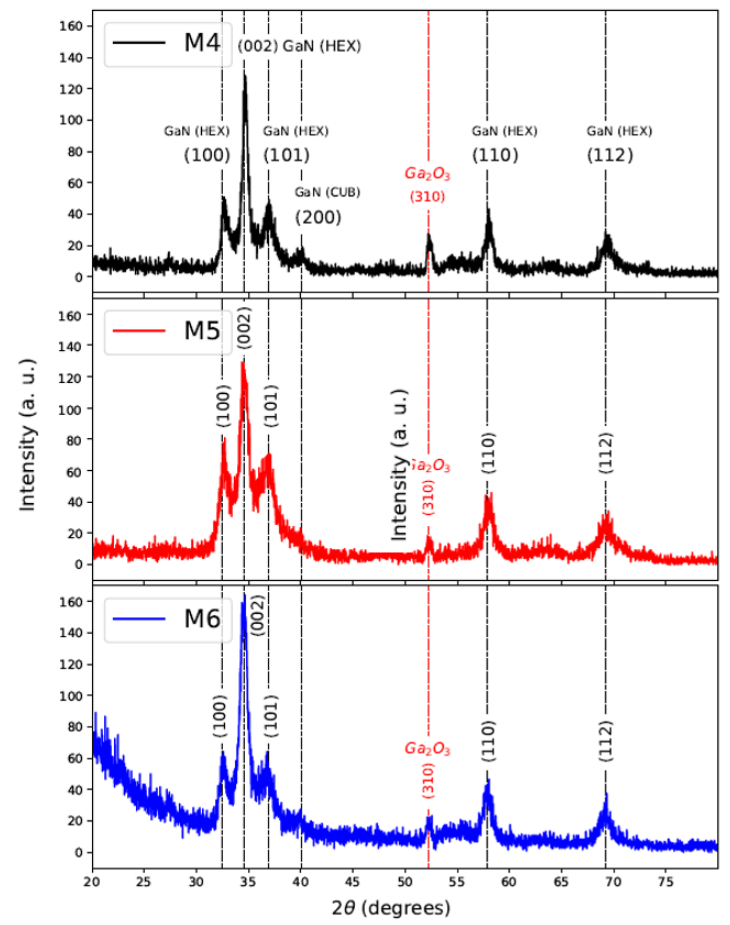
Figure 5. XRD of Nitrided samples M4, M5, and